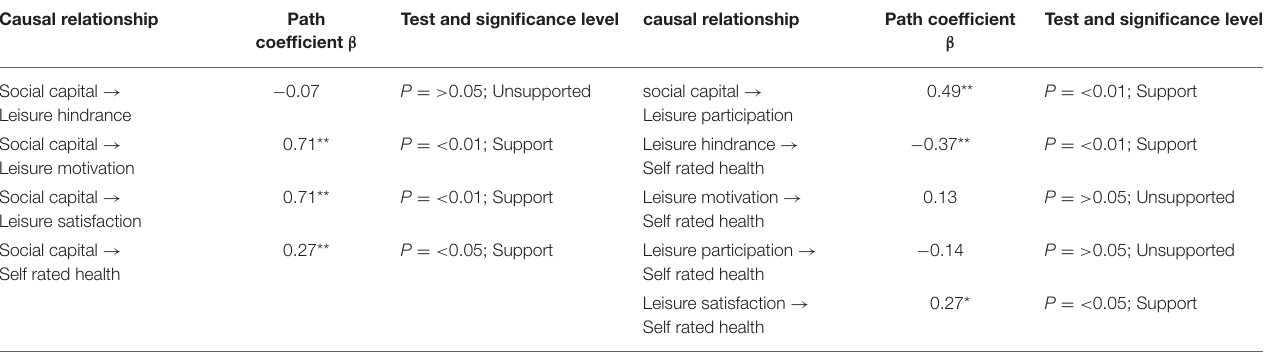
TABLE 4 | Statistics of structural fitness test of the overall sample